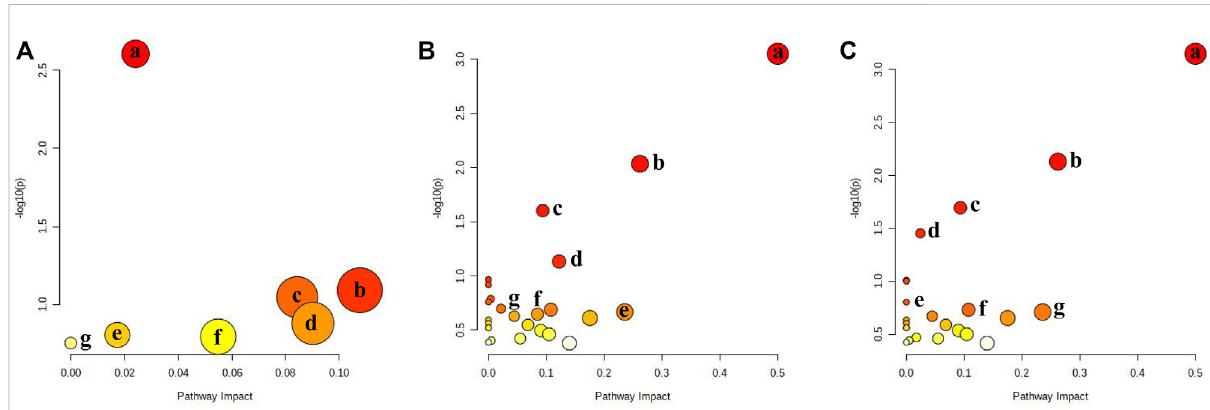
FIGURE 3 Metabolic pathway analysis for Control group vs. different stages. (A) Control group vs. early stage of HCC: a: Purine metabolism; b: Fructose and mannose metabolism; c: Ether lipid metabolism; d: Porphyrin and chlorophyll metabolism; e: Glycerophospholipid metabolism; f: Amino sugar andnucleotidesugarmetabolism;g:N-Glycanbiosynthesis; (B) Controlgroupvs.formativestageofHCC:a:Phenylalanine,tyrosine,andtryptophan biosynthesis;b:Phenylalaninemetabolism;c:Citratecycle;d:Glycerophospholipidmetabolism;e:PantothenateandCoAbiosynthesis;f:Ether lipid metabolism; g: Sphingolipid metabolism; (C) formative stage of HCC vs. CuB group: a: Phenylalanine, tyrosine, and tryptophan biosynthesis; b: Phenylalanine metabolism; c: Citrate cycle; d: Purine metabolism; e: Butanoate metabolism; f: Fructose and mannose metabolism; g: Pantothenate and CoA